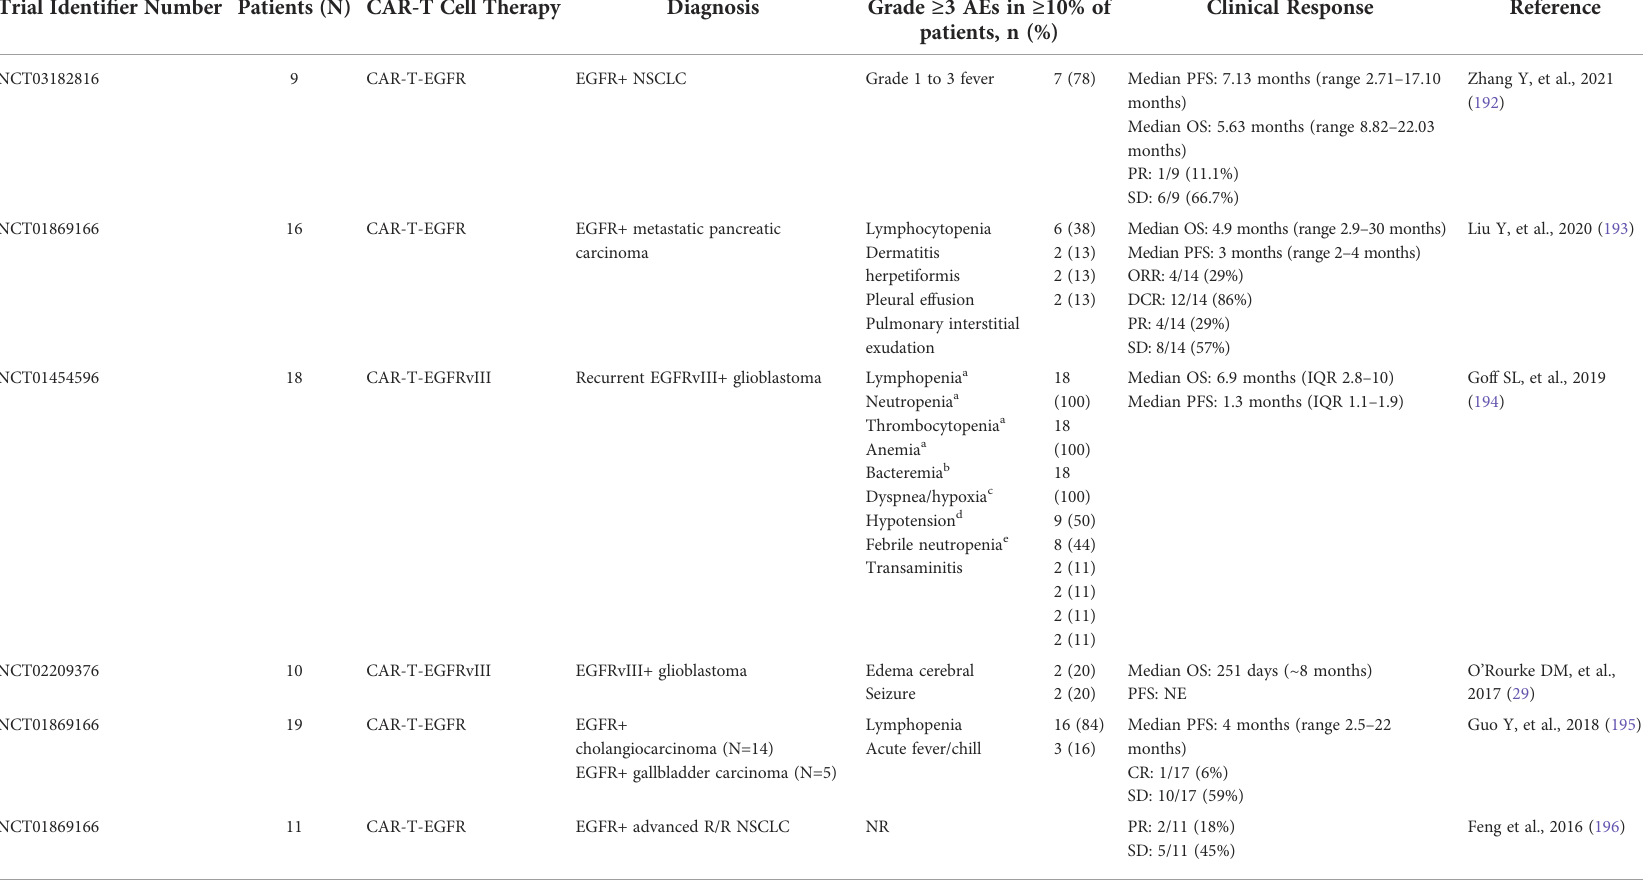
TABLE 2 Safety and clinical response to CAR-T therapies in phase I clinical